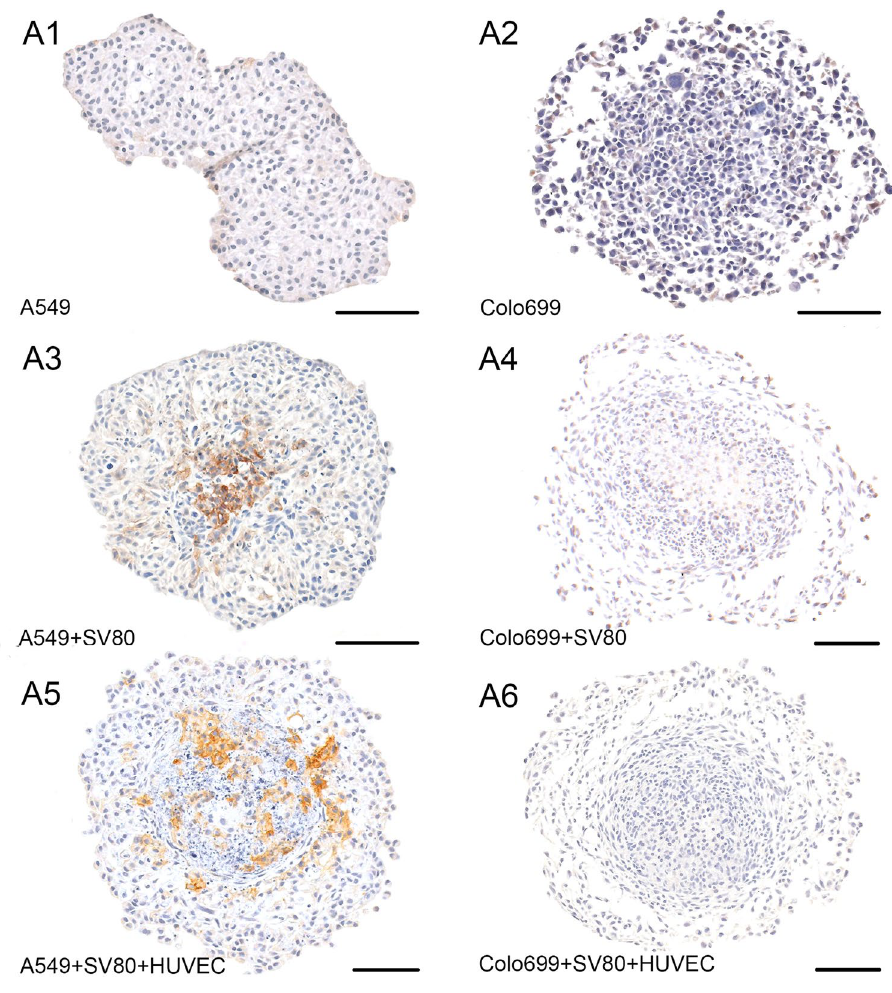
Figure 8. Oxygen deprivation leading to hypoxia: Carboanhydrase IX (CA IX) was analysed to identify hypoxia in ten day old microtissues (A1–6). This enzyme was only expressed in microtissues that consisted not only of cancer cells but also of the stromal compartment (A3–6). However, CA IX was secreted predominantly in microtissues consisting of A549 cancer cells (A3 + A5). Both cancer cell line monocultures as well as Colo699 co-cultures showed no signs for hypoxia. Bar: 100 µ